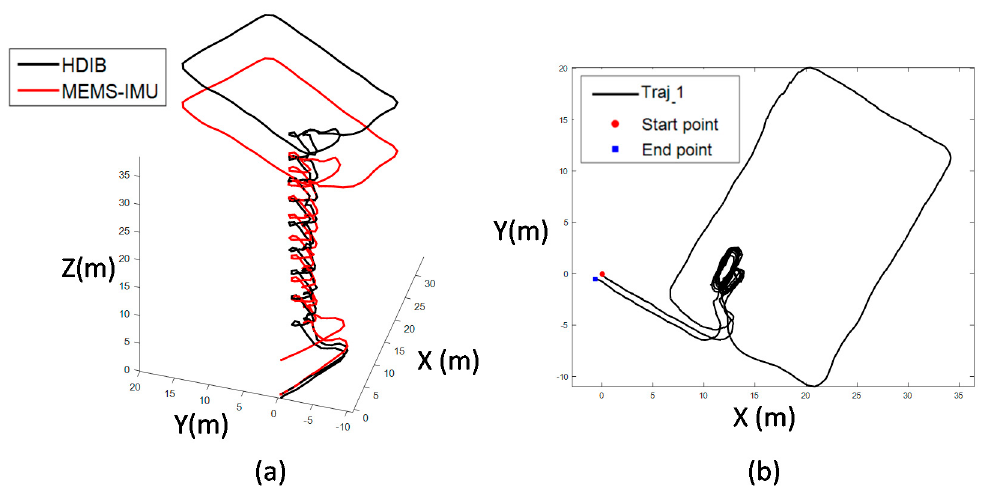
Figure 28. Positioning result of Traj_1; ( a ) is the 3D view of the positioning result; ( b ) is the top view of the positioning result. TTDE of Traj_1 is 0.32% and the height error is 0.68 m. Traj_2 is a mix of walking on the flat, ascending and descending the stairs. The total travelled distance is 368 m with 5 floor up/down. The 3D and top view of Traj_2 positioning result is shown in Figure 29. TTDE of Traj_2 is 0.76% and the height error is 0.27 m.